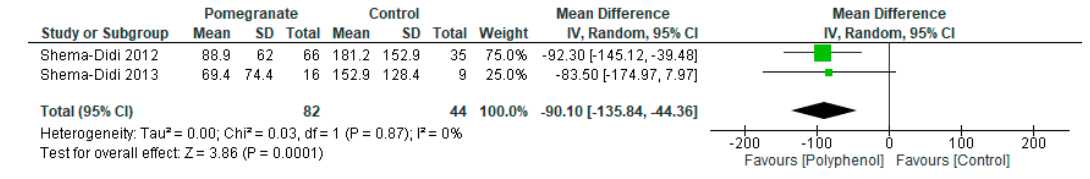
Figure 2. Forest plot of polyphenol-rich interventions on myeloperoxidase.